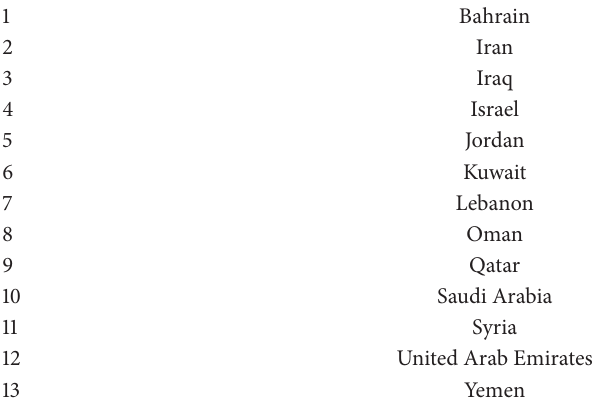
Table 5: Countries considered in the Middle East region. Table 6: Countries considered in the African